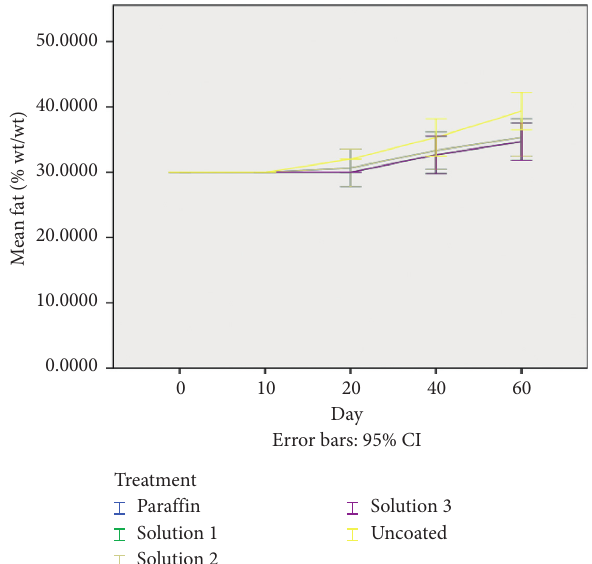
Figure 12: Values (means ± SD) of the hardness of cheese coated with antimicrobial edible coating solutions—solution 1 (0.250 g/L Delvocid), solution 2 (0.275g/L Delvocid), and solution 3 (0.300 g/ L Delvocid)—compared with cheese coated with commercial coating and uncoated cheese throughout 60d of storage at 10 ° C and 85% relative